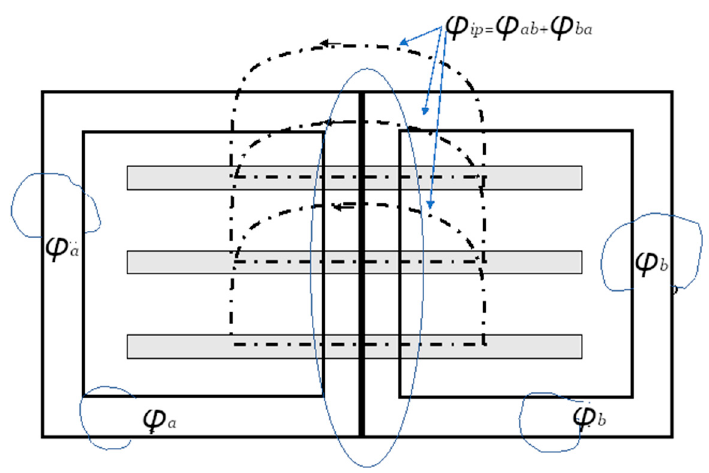
Figure 4. DD (two D-shaped coils) pad design with a highlight on the main flux components [21].